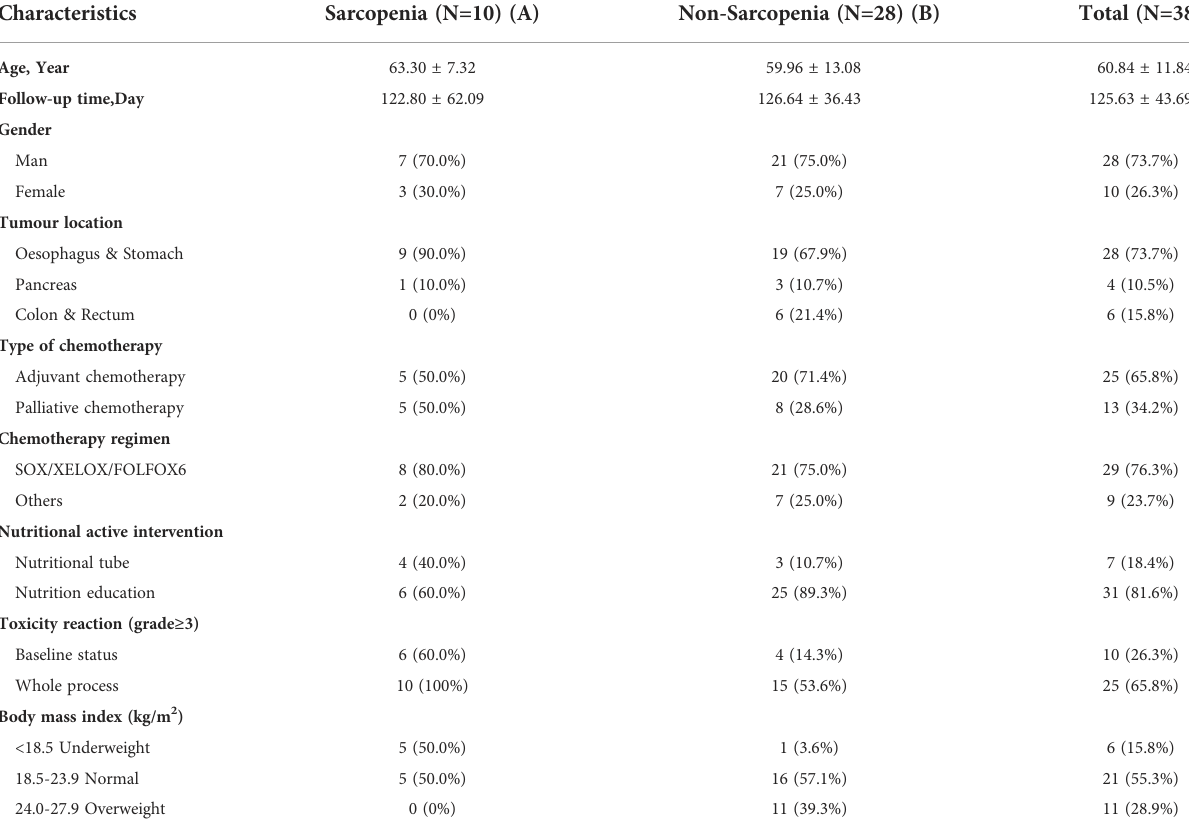
TABLE 1 Clinical characteristics of